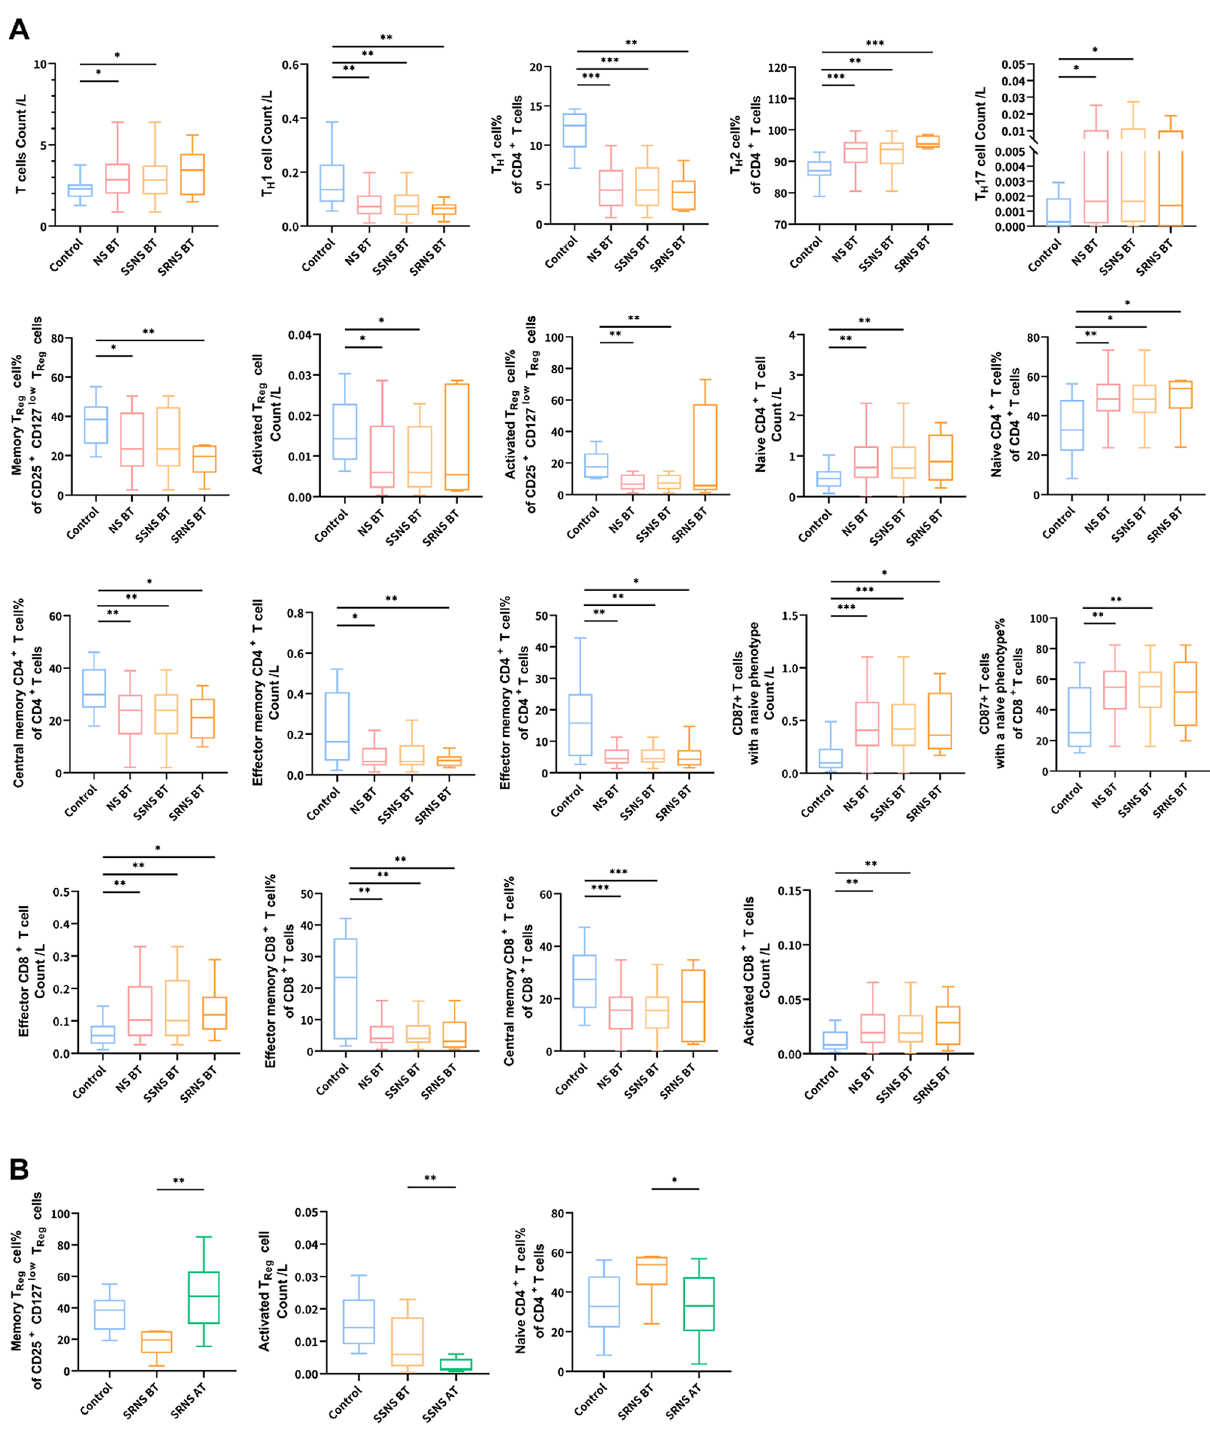
Figure 1. Changes of T cells in peripheral blood of patients with nephrotic syndrome. (A) Changes of T cells in peripheral blood of patients with nephrotic syndrome before treatment compared with normal control; (B) changes of T cells in peripheral blood of patients with nephrotic syndrome before and after treatment. Control normal control (n = 30), NS nephrotic syndrome (n = 85), SSNS steroid-sensitive nephrotic syndrome (n = 59), SRNS steroid-resistant nephrotic syndrome (n = 26), BT before treatment, AT after